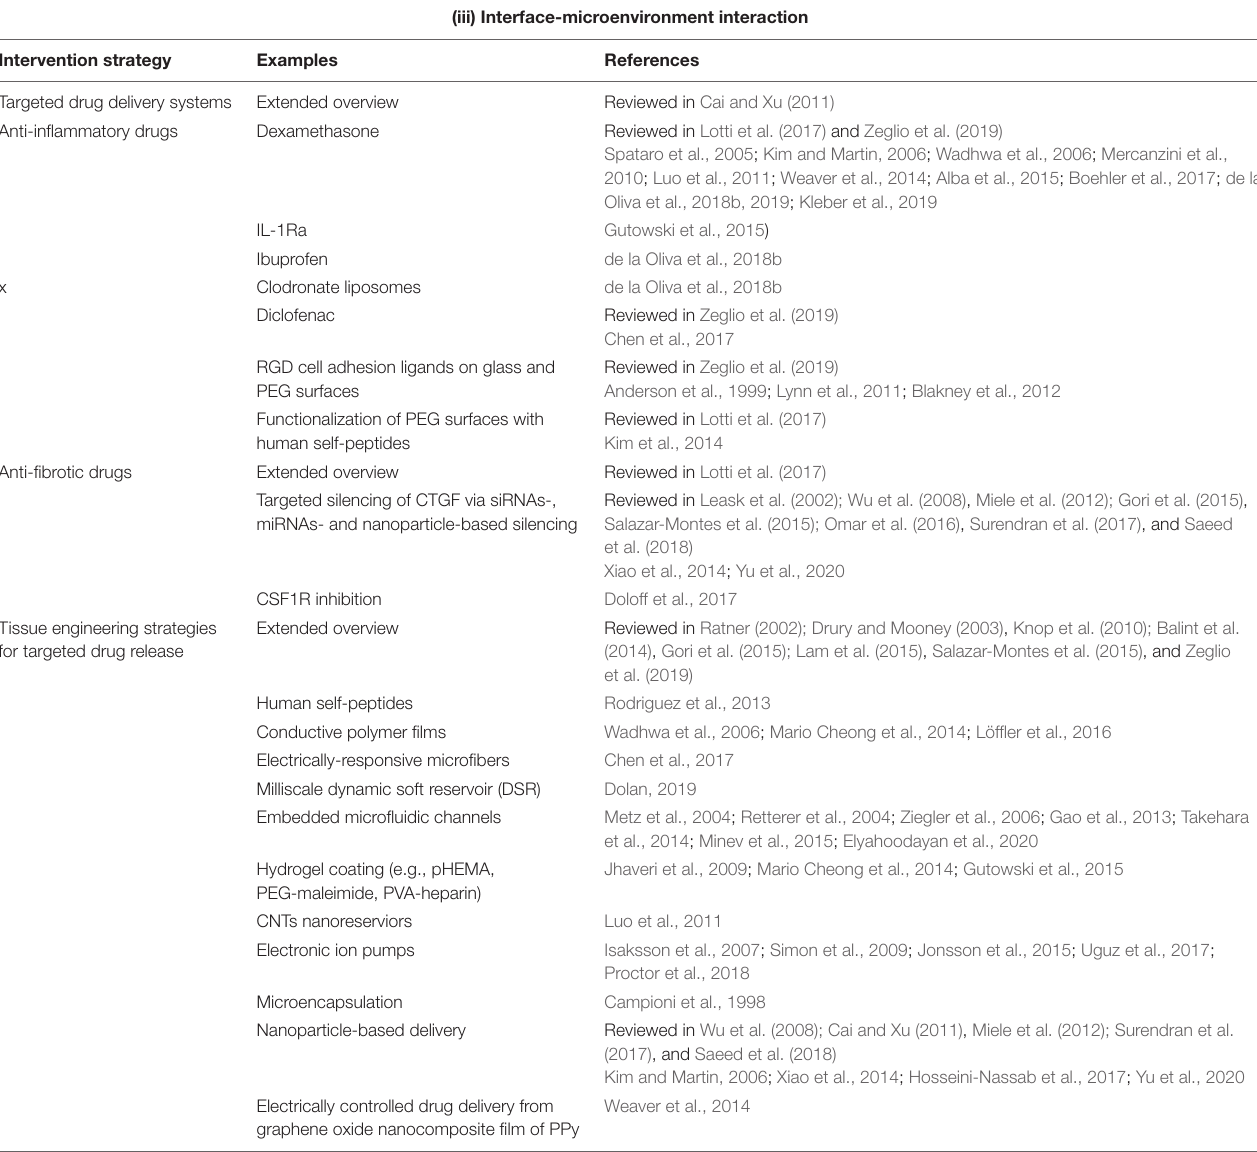
TABLE 3 | Intervention strategies based on the control of the interface-microenvironment interaction. (iii) Interface-microenvironment